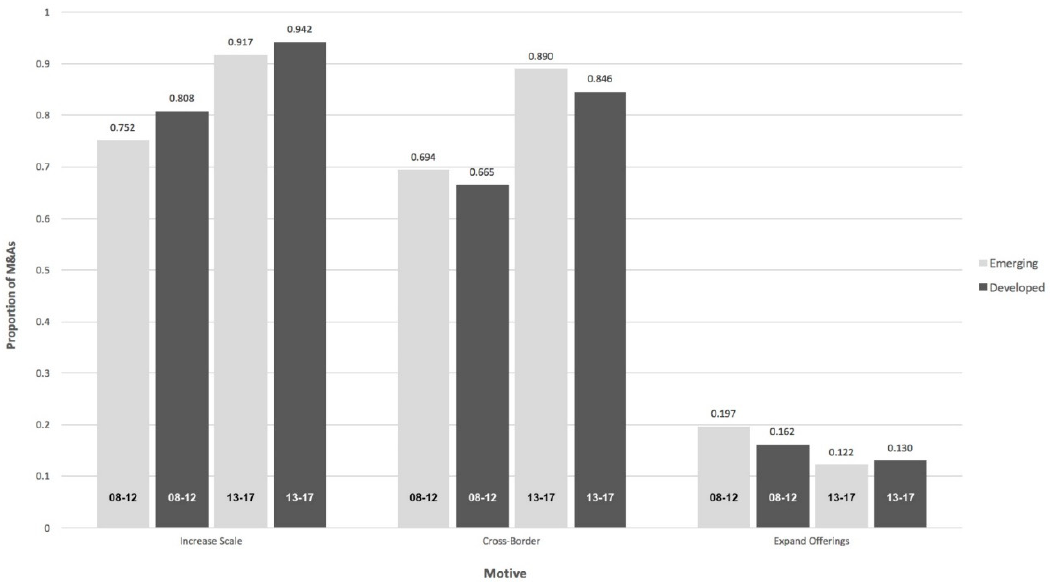
Figure A2. Value and share of cross-border M&As by purchasers from the Asia-Pacific region, 2000 – 2020. Source: calcu- lated by authors from the UNCTAD data provided at https://worldinvestmentreport.unctad.org/annex-tables/ (25 Sep- tember 2021). Note: the Asia-Pacific region is defined as Asia, Australia, New Zealand and Oceania (based on the UNCTAD data).